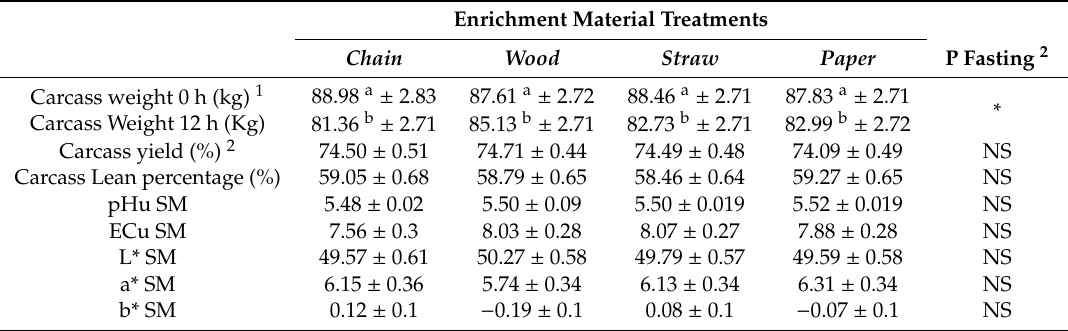
Table 5. Means (and standard deviations) of carcass and meat quality parameters for the four types of enrichment material after implementing two di ff erent fasting times (0 and 12